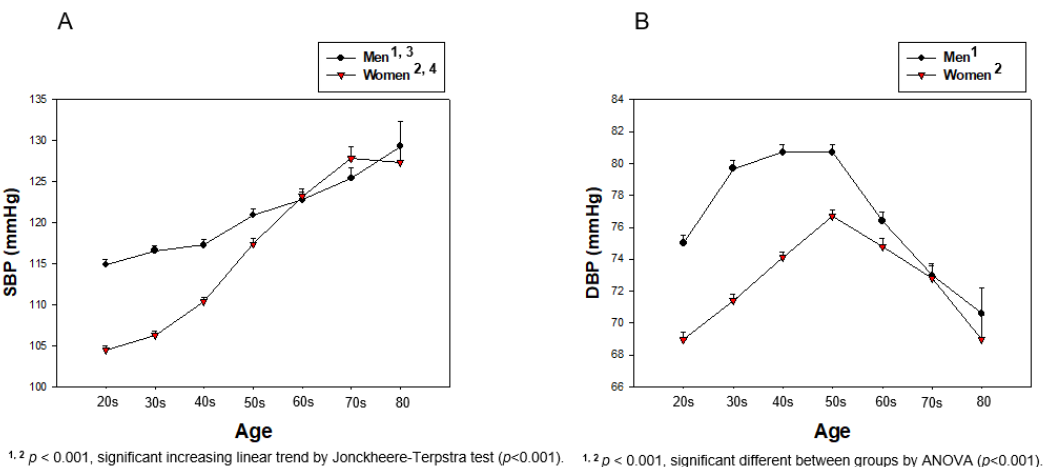
Figure 9. Change in SBP (A) and DBP (B) depends on age of men and women during entire life.